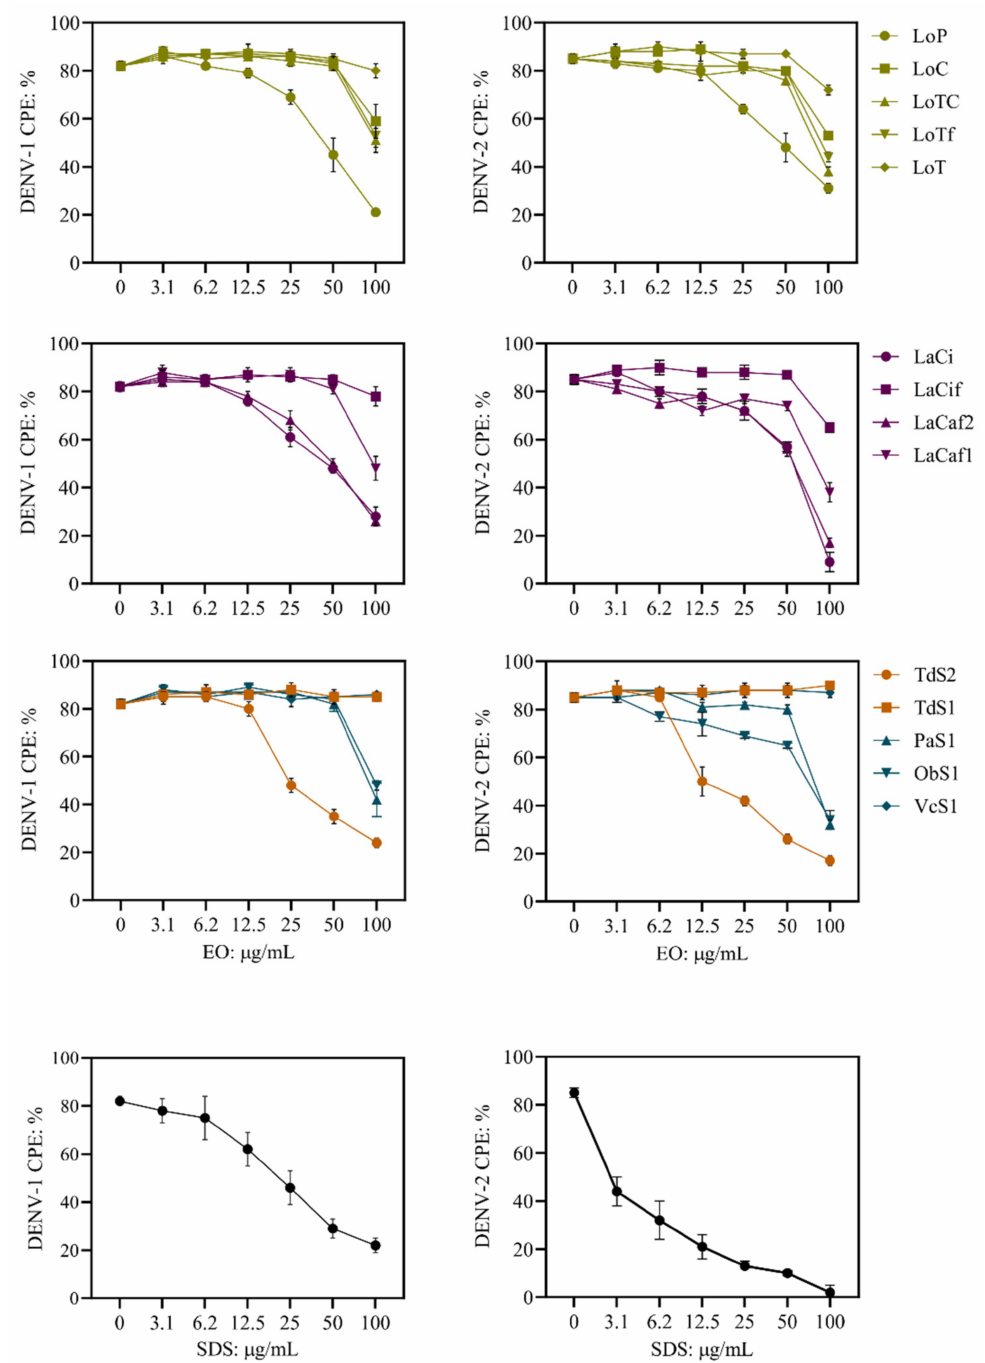
Figure 1. Results of cytopathic effect (CPE)-based assays to evaluate the antiviral activities of the essential oils against dengue viruses (DENV-1 and DENV-2). Quantification of crystal violet staining was performed to measure virus-induced CPE. % DENV-CPE = [(OD 570 of infected and treated cells/OD 570 of non-infected non-treated]. EO samples (Table 1): L. origanoides (LoP, LoC, LoTC, LoTf, and LoT); L. alba (LaCi, LaCif, LaCaf2, LaCaf1); T. diffusa (TdS1 and TdS2); O. basilicum (ObS1); P. aduncum (PaS1) and V. curassavica (VcS1). Sodium dodecyl sulfate (SDS) is an antiviral compound. Data are expressed as the mean ± SD from six independent